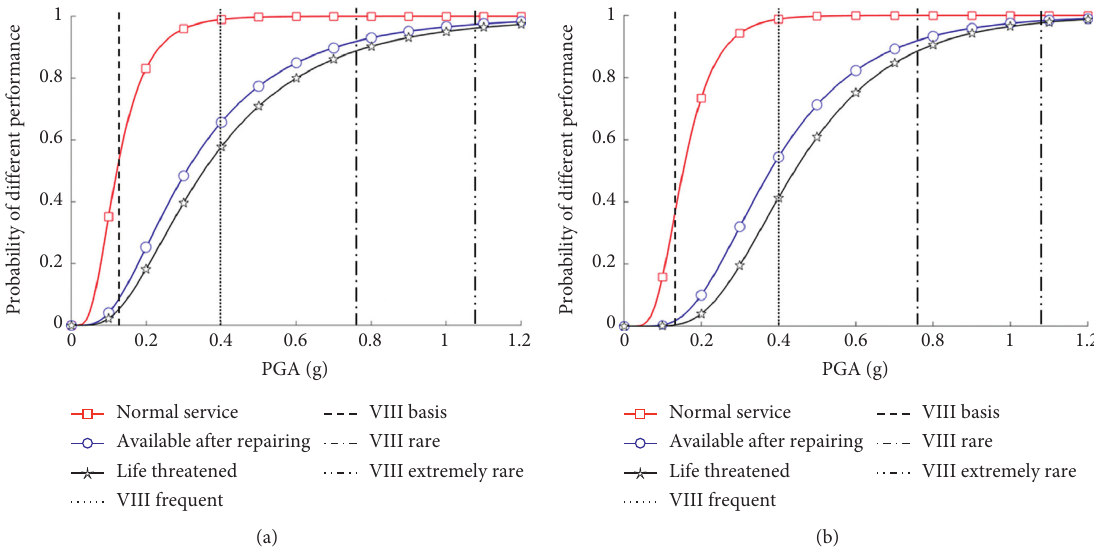
Figure 11: The seismic vulnerability curve of the tunnel structure under the action of different ground motions: (a) near-fault pulsed; (b) far- field.